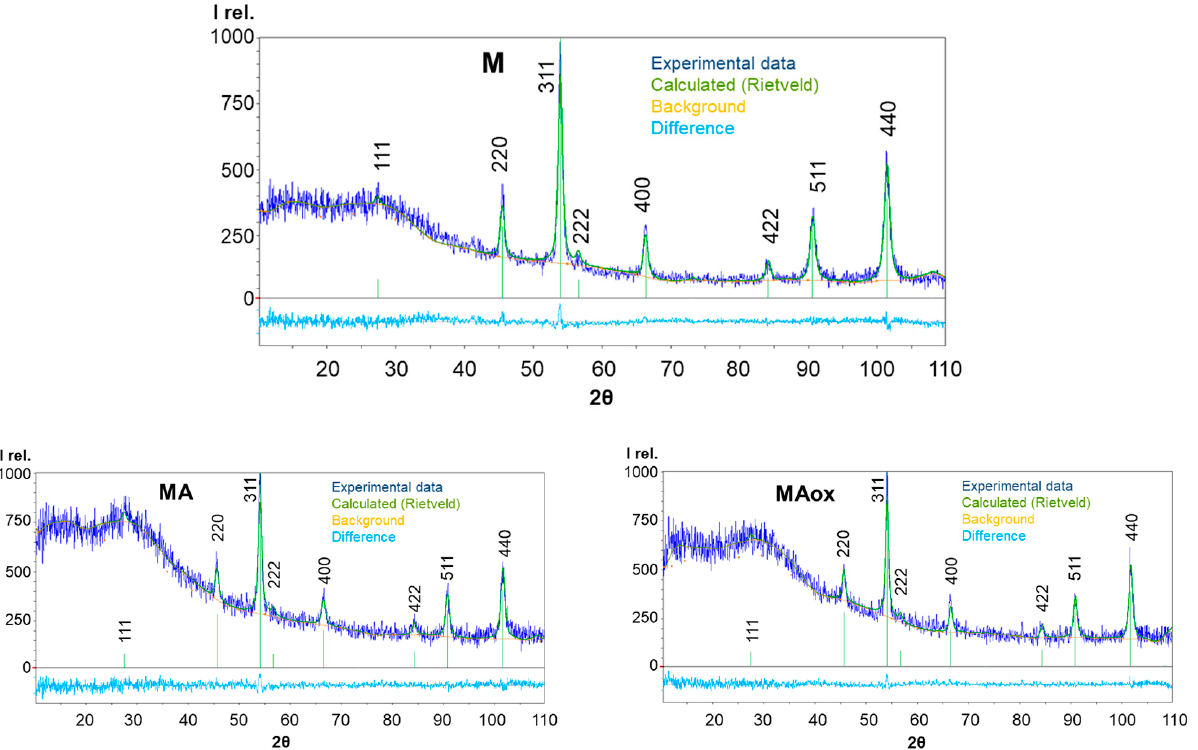
Figure 1. Experimental diffraction patterns of samples M, MA, MAox, and the results of their refinement by the Rietveld method.